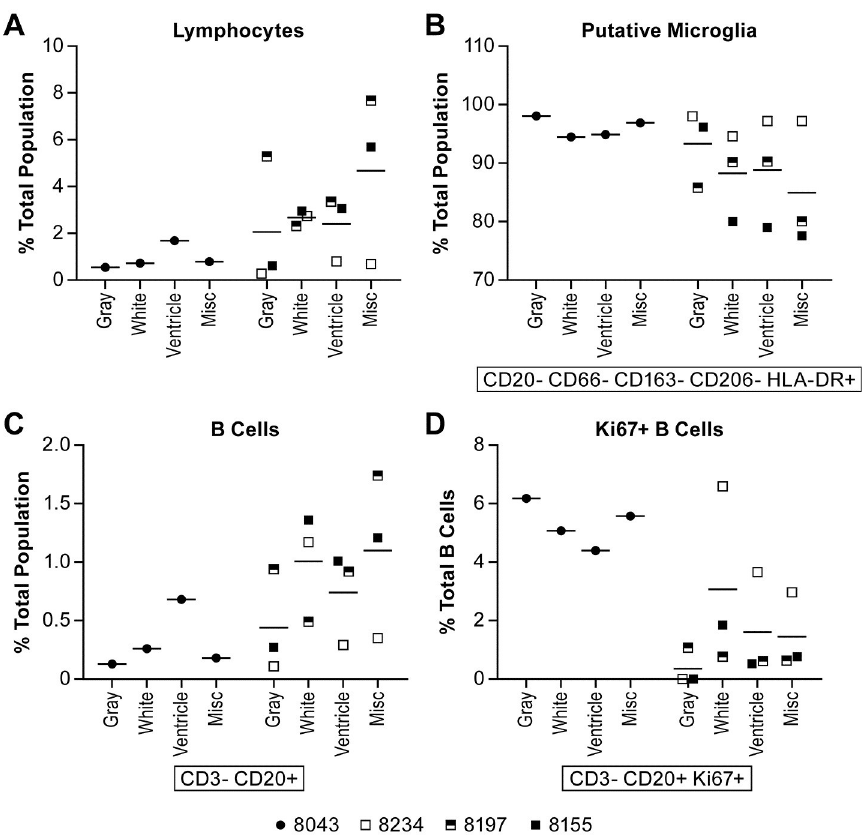
Fig 10. Lymphocyte, microglia and B cell populations in the brain. Flow cytometric analysis of cell populations in brain tissue collected at necropsy. Tissues were not collected from two animals due to tissue degradation. For each animal, samples were collected from three different regions of the brain, the gray matter, white matter and tissue immediately adjacent to the ventricles to include the ependyma. A random tissue section was also collected (Misc) if it appeared on gross examination to be of interest. The specific markers used to distinguish cell populations are indicated below the individual panels. Analyses included the Ki67 marker in B cells to determine if cell populations were proliferating. Animals included in this analysis included 8043 (filled circle), 8234 (open square), 8197 (half filled square) and 8155 (filled square). Individual cell populations included (A) lymphocytes; (B) putative microglia; (C) B cells; (D) Ki67+ B cells. Markers and antibody clones used for these analyses can be found in S3 Table. The solid lines represent the mean for that dose